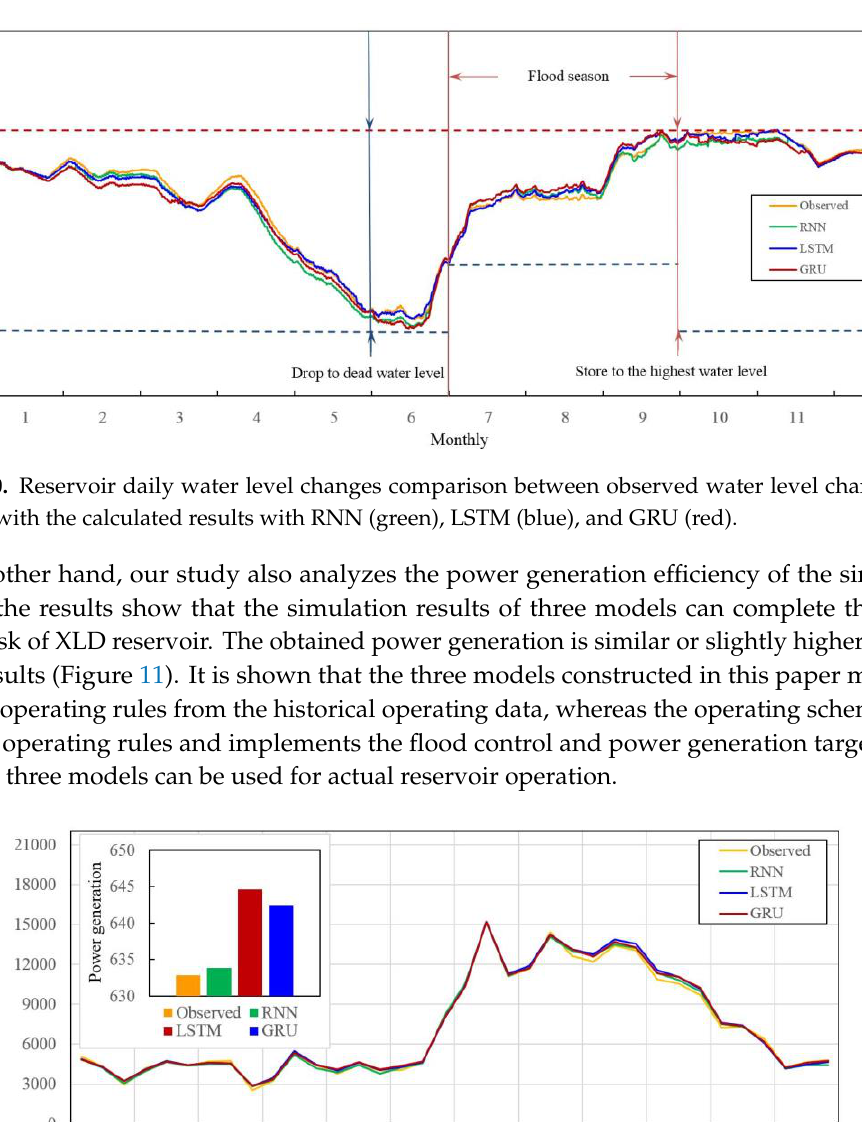
Figure 11. Reservoir daily water level changes comparison between observed water level changes (yellow) with the calculated results with RNN (green), LSTM (blue), and GRU (red).